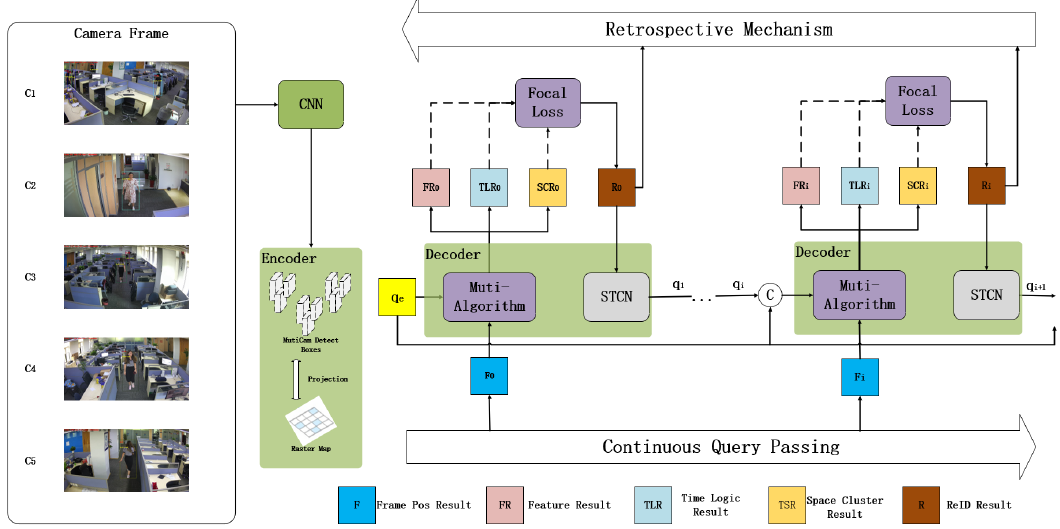
Figure 1. Overall algorithm structure.